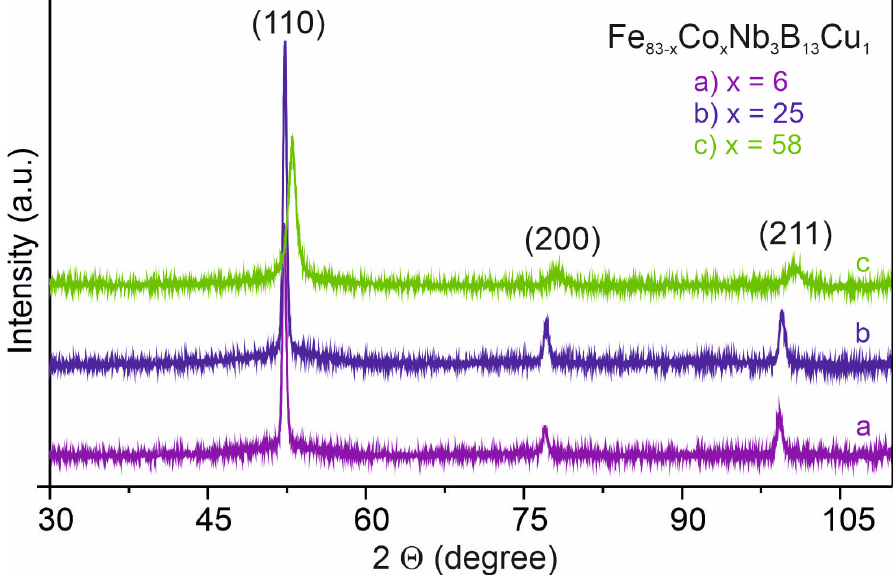
Figure 1. XRD patterns for Fe 83 − x Co x Nb 3 B 13 Cu 1 (x = 6 (a), 25 (b), and 58 (c)) alloys annealed at 750 K for 10 min.